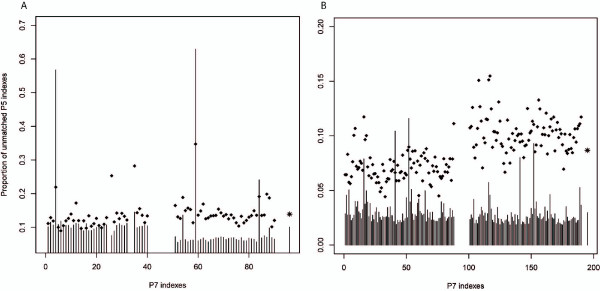
Chimeric read fraction estimated from double indexed libraries. P5 is the index inserted at the 5' end and P7 is the index inserted at the 3' end of the template DNA. Diamonds represent the fraction of the unmatched P5-P7 reads among all reads; the vertical line represents the fraction of the most abundant unmatched P5 component among all unmatched P5 components, while the rightmost column shows the average value of all P7 indexes. (a, b) The multiplexed sample sizes are 40 (a) and 90 (b), and each includes two independent libraries.